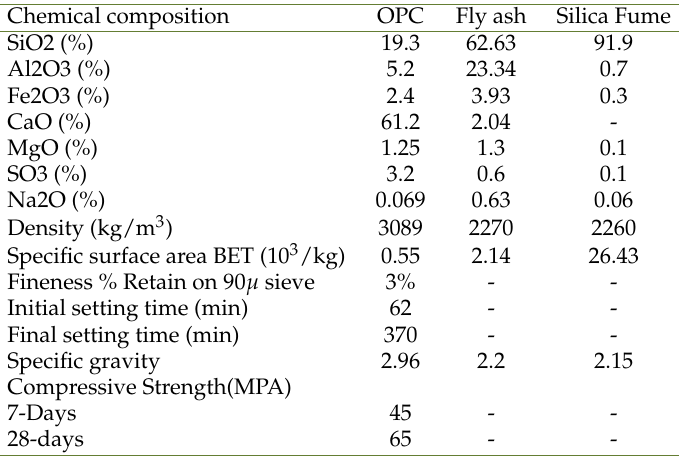
Table 1. Properties of materials used in concrete